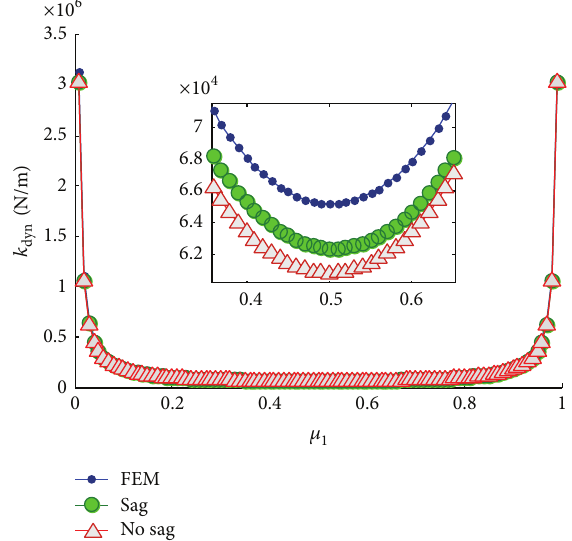
Figure 8: A comparison between the static stiffness of cables with a single transverse degree of freedom using different methods ( 𝜔 = 0